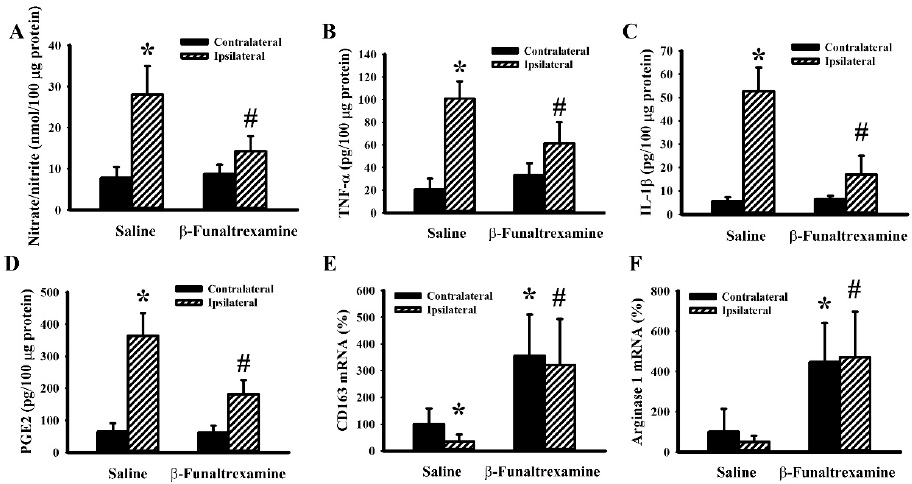
Figure 7. β -funaltrexamine alleviated cerebral I / R-induced neurotoxic cytokine production. Rats receiving normal saline vehicle or β -funaltrexamine (82.5 nmol / 30 µ L) intracerebroventricular infusion were subjected to both CCAs and the right MCA occlusion for 90 min followed by 24-h reperfusion. Total homogenates (ipsilateral and contralateral cortical tissues) were subjected to Griess reagent or ELISA for the measurement of NO ( A ), TNF- α ( B ), IL-1 β ( C ), and PGE2 ( D ) content. Total cellular RNAs were isolated from the ipsilateral and contralateral cortical tissues and subjected to quantitative RT-PCR for the measurement of CD163 ( E ) and arginase 1 ( F ) mRNA content. * p < 0.05 vs. the contralateral tissues of the vehicle groups and # p < 0.05 vs. the ipsilateral tissues of the vehicle groups, n =